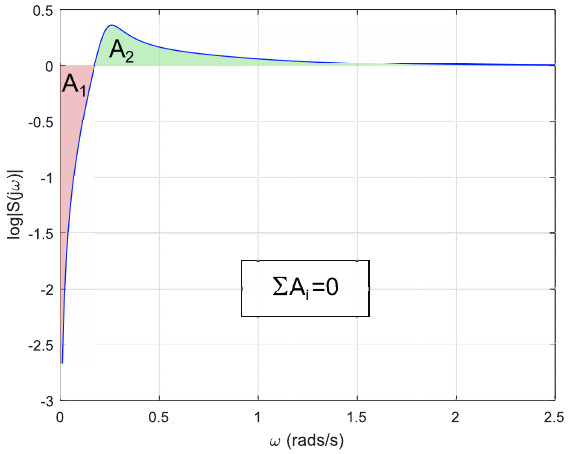
Figure 18. Sensitivity function of a linear system.